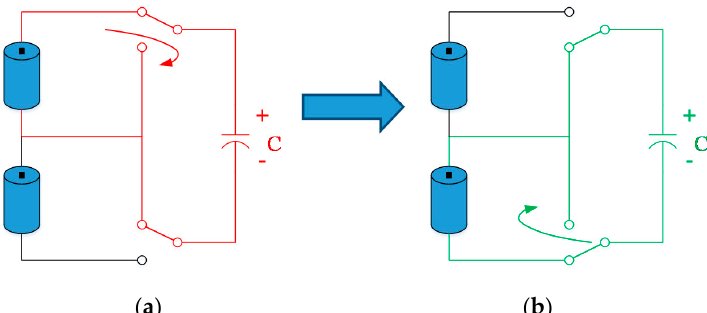
Figure 2. Principle of switch capacitor balance. ( a ) Energy transfer from cell to capacitor; ( b ) Energy transfer from capacitor to cell.